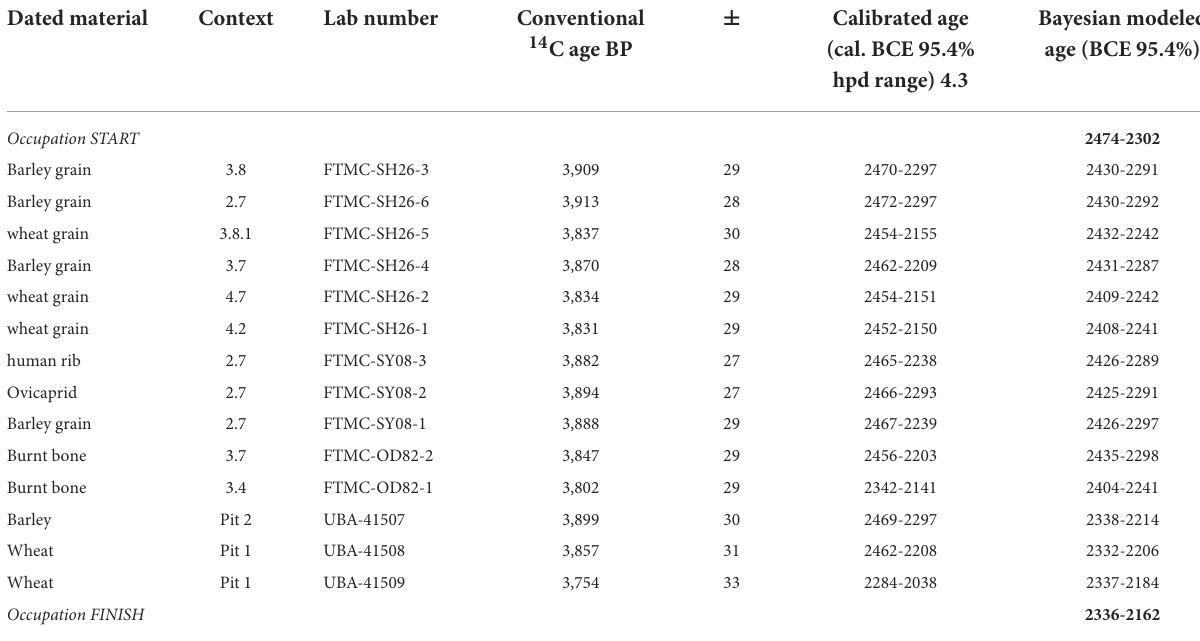
TABLE 2 Radiocarbon dates from the Chap II site according to the